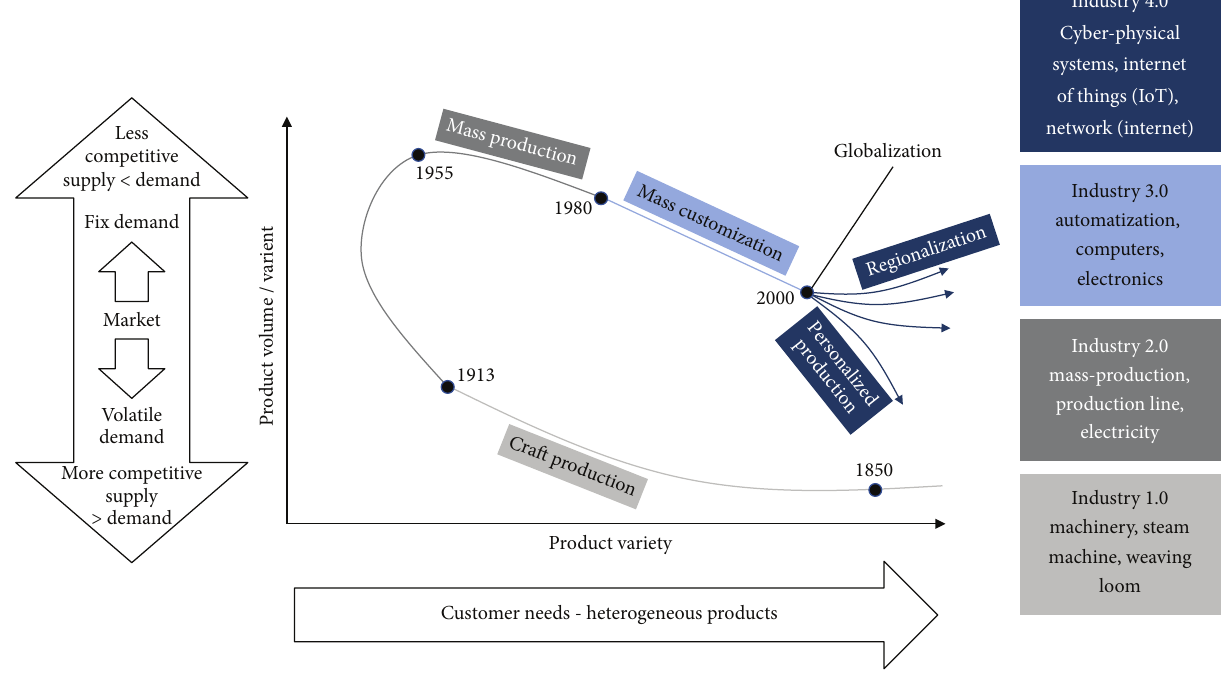
Figure 1: The evolution of industry and the change in drivers. Table 1: Optimization issues in Industry 4.0